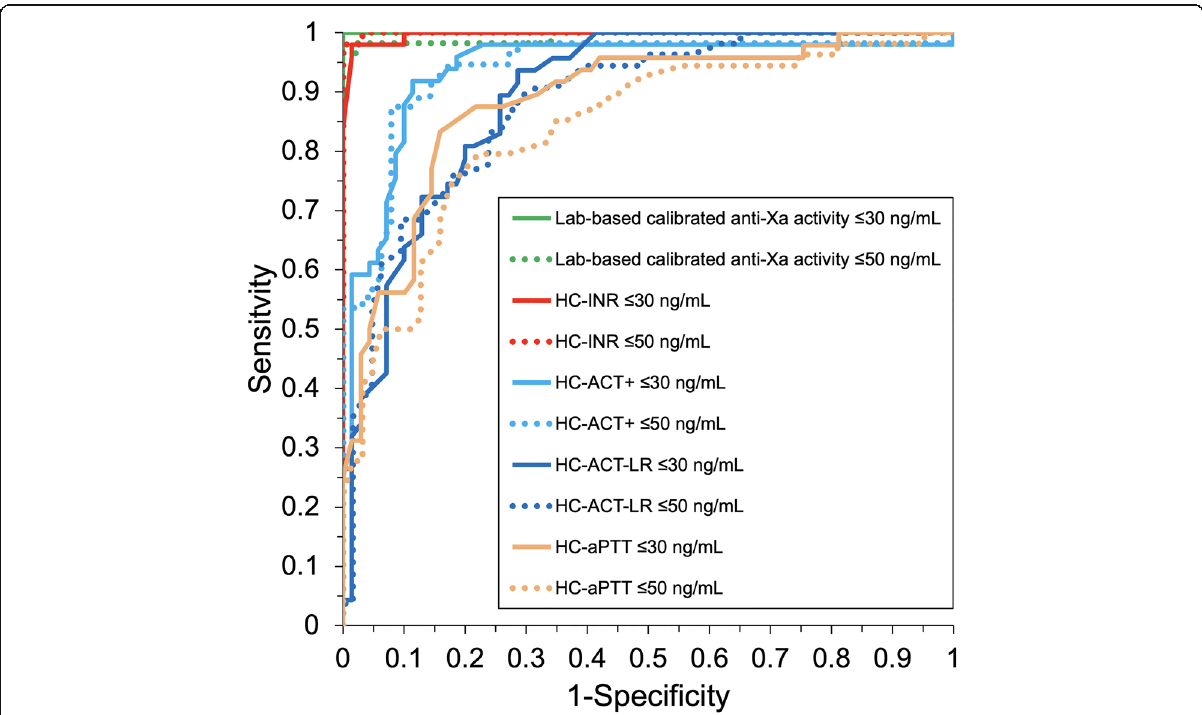
Fig. 3 Percentage of edoxaban concentrations up to 30 ng/mL (light gray), > 30 and ≤ 50 ng/mL (dark gray) and > 50 ng/mL (black) found at corresponding laboratory-based calibrated anti-Xa activity and the ‘ ideal cut-offs ’ for Hemochron ™ Signature Elite point-of-care test system-based prothrombin time/INR (HC-INR) and activated clotting time (HC-ACT+)